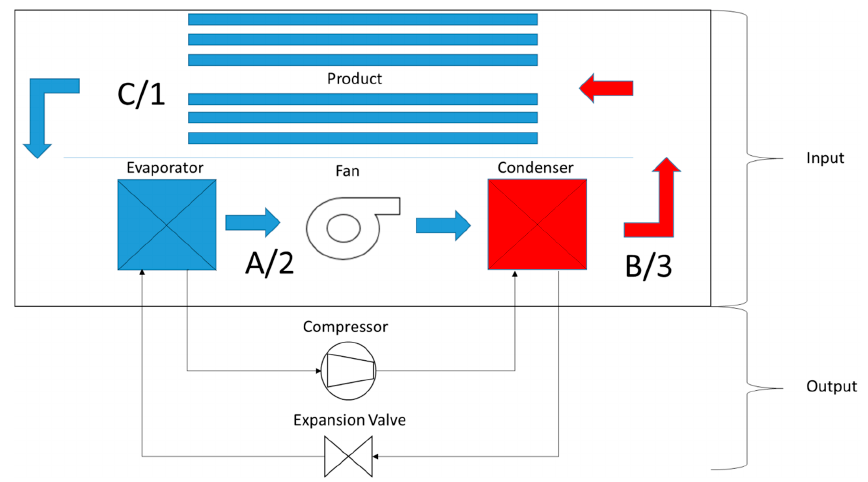
Figure 1. Scheme of a specific prototype of a heat pump food dryer tested for this algorithm where the thin line represents the refrigerant circuit while the thick arrows represent the airflow circuit.